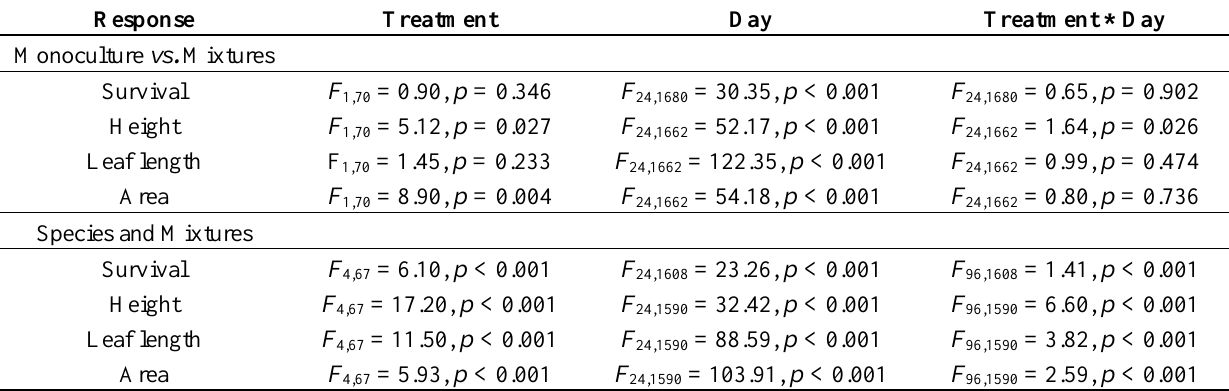
Figure 1. Mean (± SEM) ( a ) number of plants surviving within a pot; ( b ) height of the tallest plant per pot; ( c ) length of the leaves per pot, and ( d ) plant area in monoculture and mixture grain pots for each collection day. Table 2. Results of repeated measures ANOVAs testing the effect of diversity (monocultures vs. mixtures) and the effect of species or mixtures on banker plant growth